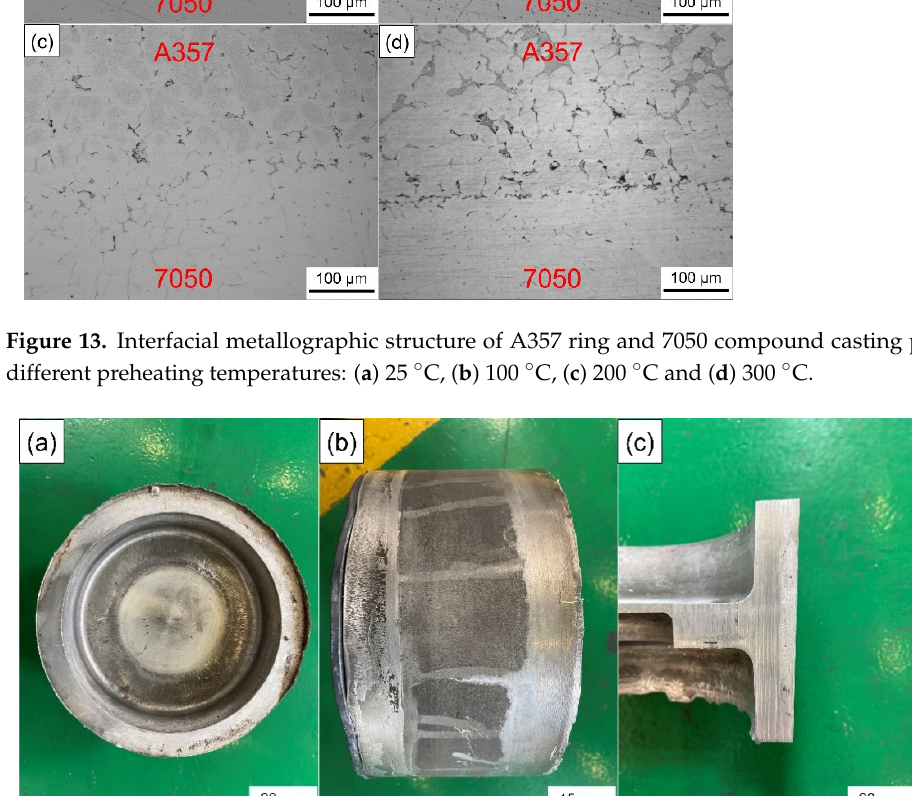
Figure 15. Optical metallography of the solid–liquid bonding interface in as-cast ( a ) and T6 ( b ) status. Figure 16 shows the SEM backscattering of the solid–liquid bonding interface of the layered composite. The solid–liquid bonding interface of the as-cast sample had a diffu- sion layer of about 200 μ m. Different from the original microstructure, in the transition zone, bright white phase appeared and was distributed among α -Al grains accompanied with SiC p . After T6 heat treatment, the bright white phase in the transition zone disap- peared and a gray phase appeared, while a black intergranular phase appeared in the 7050 side, which was consistent with the optical photograph, as shown in Figure 15.